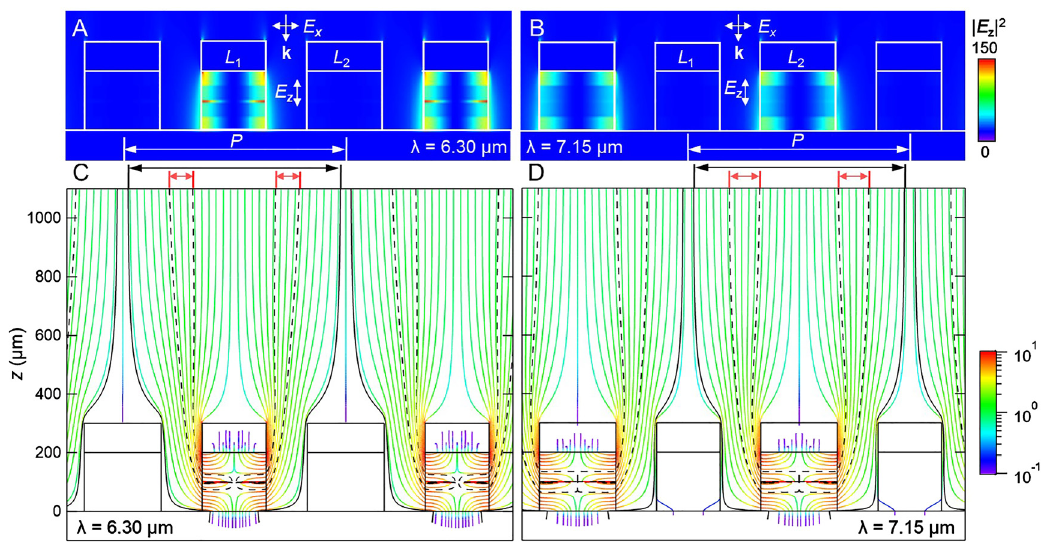
Figure 3: Photon sorting over two periods P for Device 2 ( L 1 = 0.89 µm, L 2 = 1.07 µm, and P = 3.1 µm) at λ = 6.30 µm and λ = 7.15 µm, respectively. A, B) Calculated | E z | 2 inDevice2. E x and k indicate theelectric fi eld andwavevector of incident light.C, D) Power fl ow inDevice2. Streamlinesarespacedevery100nmat z =1100nm. Solidblack linesandblackarrowsdescribethe sortingef fi ciencyofeachcavityover one period P (white arrows). Dashed lines and red arrows de fi ne the absorption by the quantum